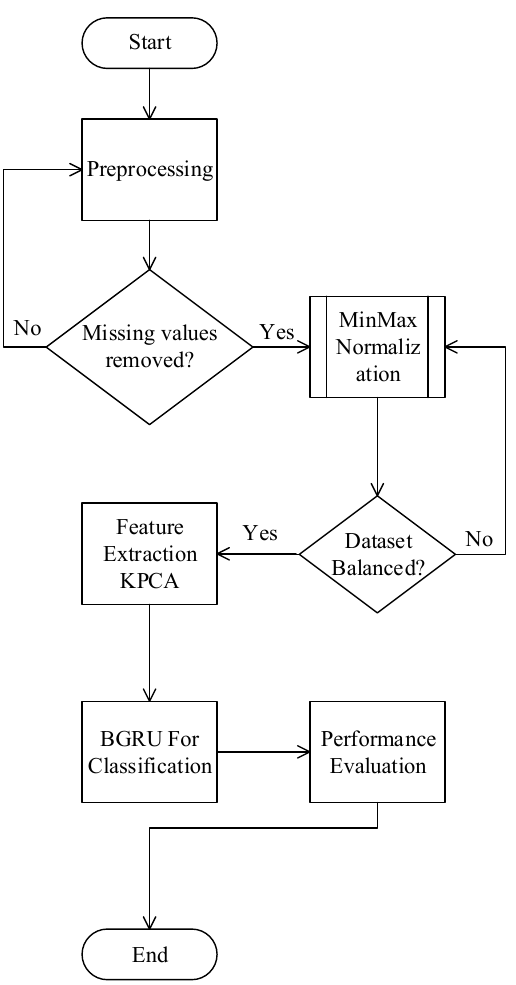
Figure 3. Flow chart of proposed system